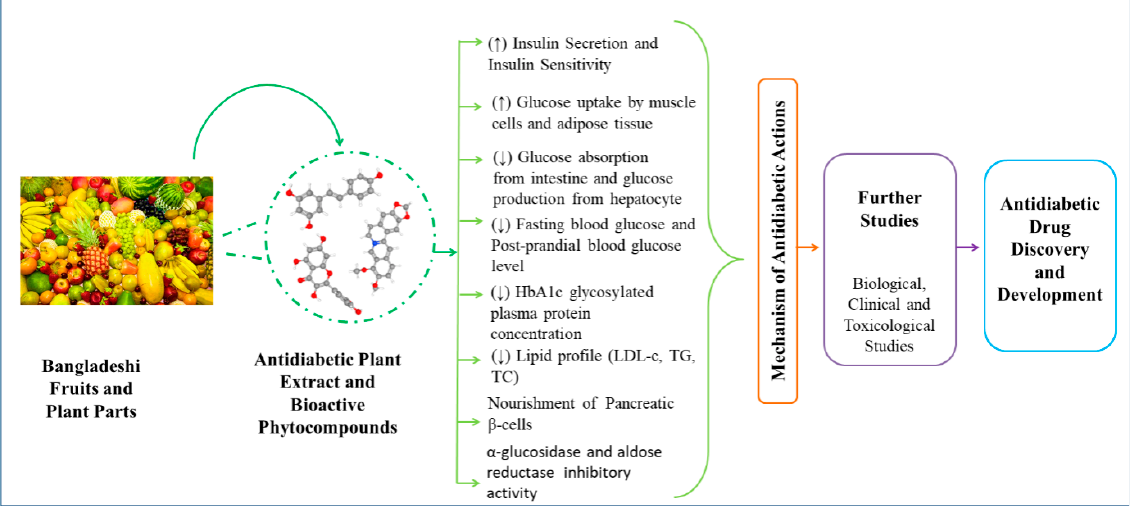
Figure 2. Commonly available Bangladeshi fruits and other plant parts for new antidiabetic drug discovery and